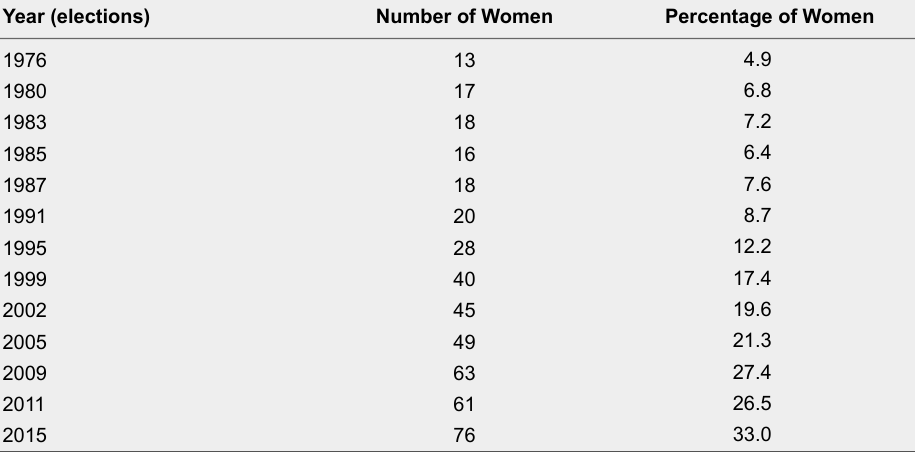
Progress in the Number and Percentage of Women in the Portuguese Parliament